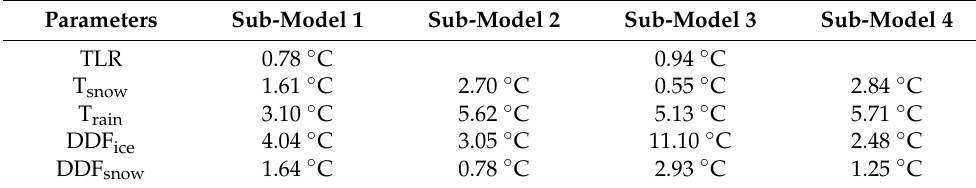
Table 3. The optimal driving data parameters of the sub-models 1–4 for the Qiyi